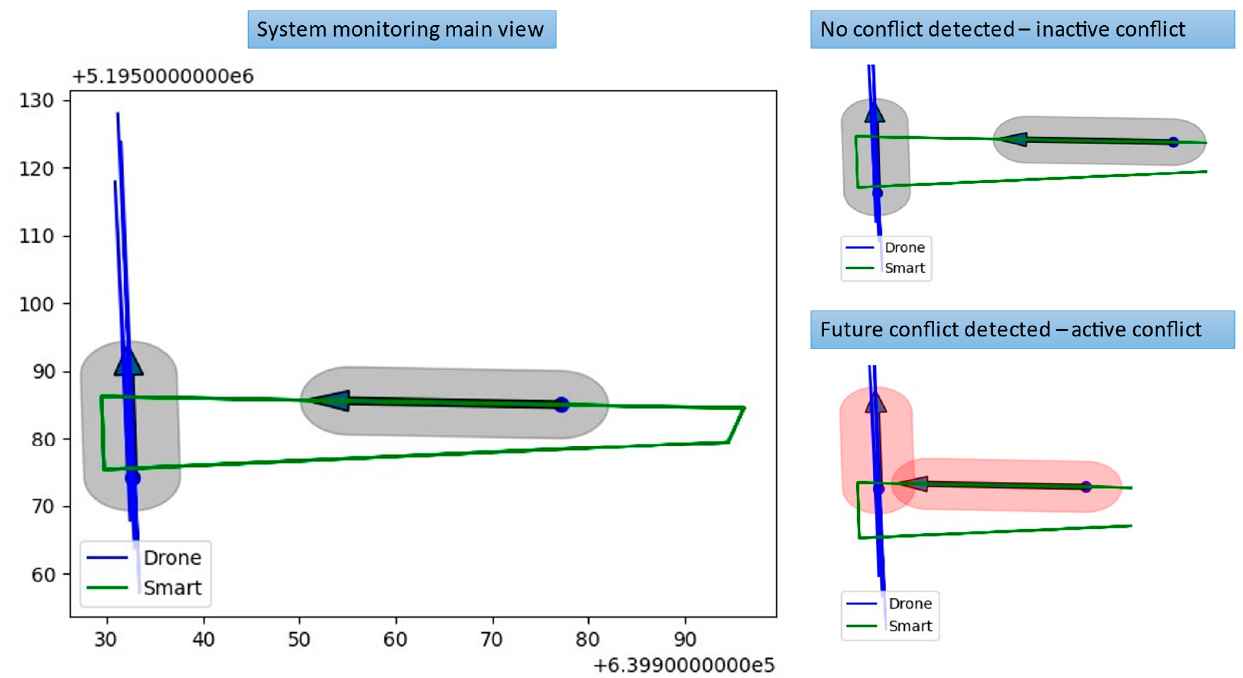
Figure 6. First version GUI display of pairwise dynamic projected area detection method; lines show user’s mission (if available), points show the current position and arrows show predicted position. The grey (inactive) and red (active) areas show the conflict area with safety buffer applied).